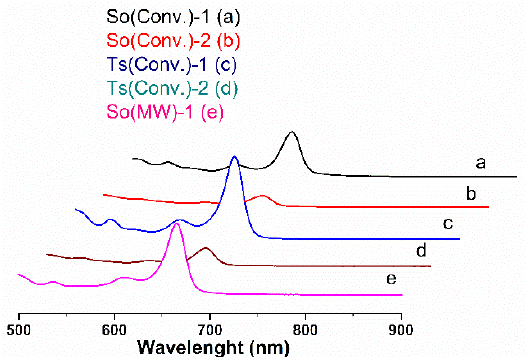
Figure 1. Chlorophyll spectra for: (a) So(Conv)-1, (b) So(Conv-2), (c) Ts(Conv)-1, (d) Ts(Conv)-2, and (e) So(MW)-1